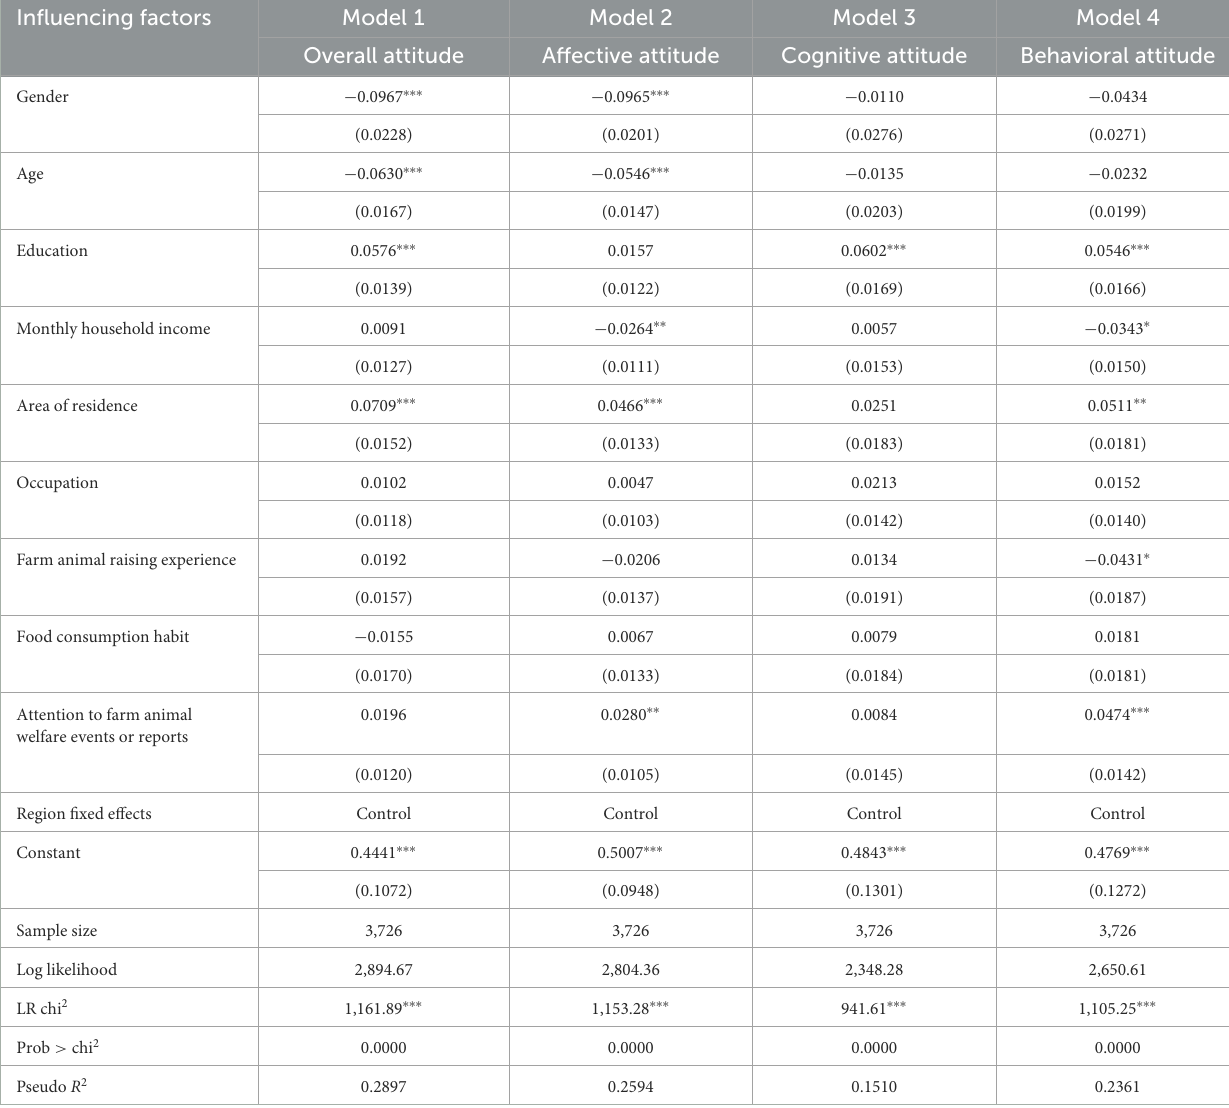
TABLE 5 Estimated results of influencing factors of public attitudes toward farm animal